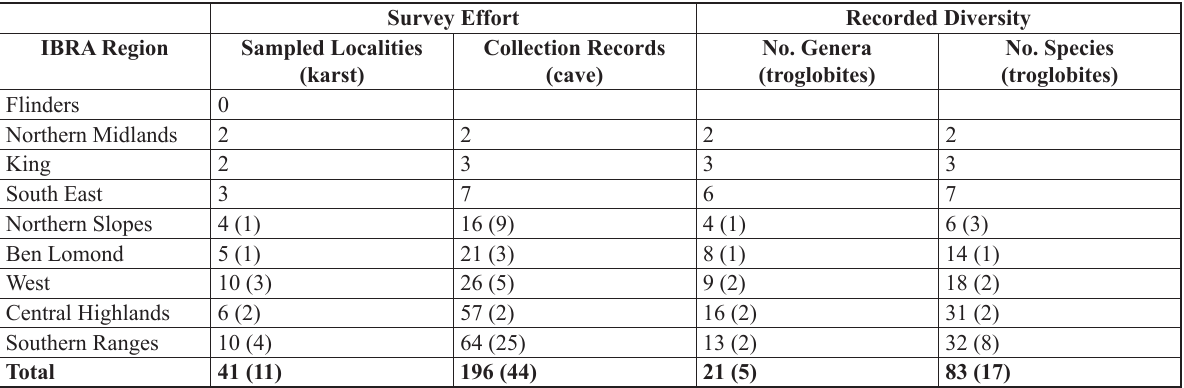
Table 1 - Survey effort and recorded diversity by IBRA region arranged in order of increased survey effort. Survey effort measured by number of sampled localities and collection records; diversity represented by number of described genera and species. Karst locali- ties and cave records / troglobitic taxa shown in brackets “(